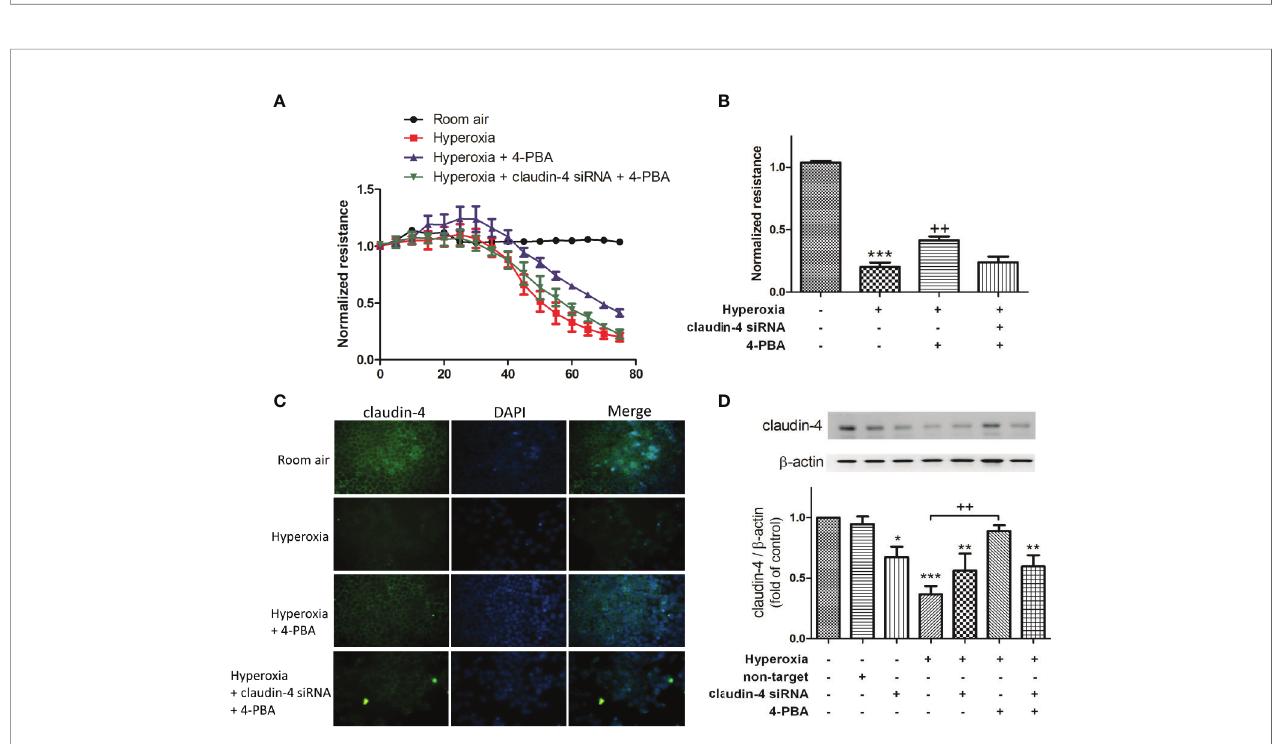
FIGURE 7 | Claudin-4 knockdown abrogates the bene fi cial effects of 4-PBA on barrier function of MLE-12 cells. (A) Dynamic measurement of barrier function in MLE-12 cells subjected to room air, hyperoxia, hyperoxia + 4-PBA, and hyperoxia + claudin-4 siRNA + 4-PBA. Depicted plots were mean normalized resistance values with standard error from 3 repeated measures in each condition (B) Quantitation of normalized resistance 72 hours in each condition in MLE-12 cells (C) Representative immuno fl uorescence staining of claudin-4 (green fl uorescence). (D) Representative Western blot and densitometry analysis of claudin-4. Data are mean ± SD, each experiment was performed at least independently in triplicate, *p < 0.05, **p < 0.01, ***p < 0.001 compared with the room air group, ++ p < 0.01, compared with the hyperoxia